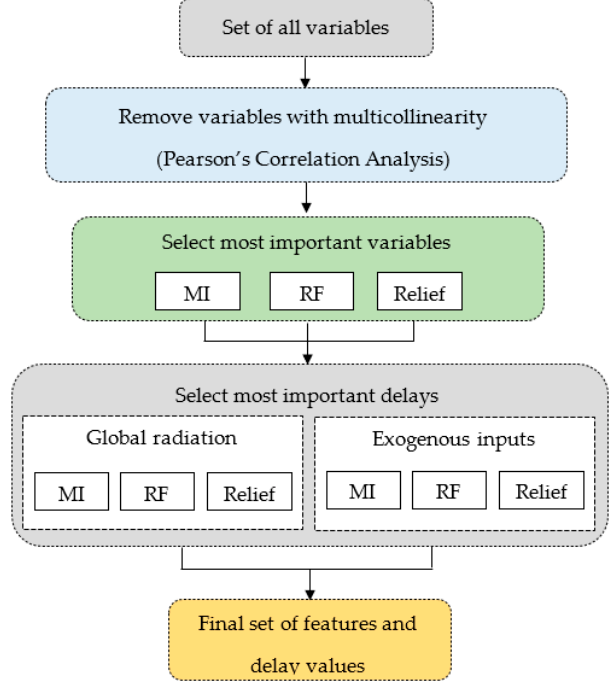
Figure 4. Ensemble feature selection methodology.